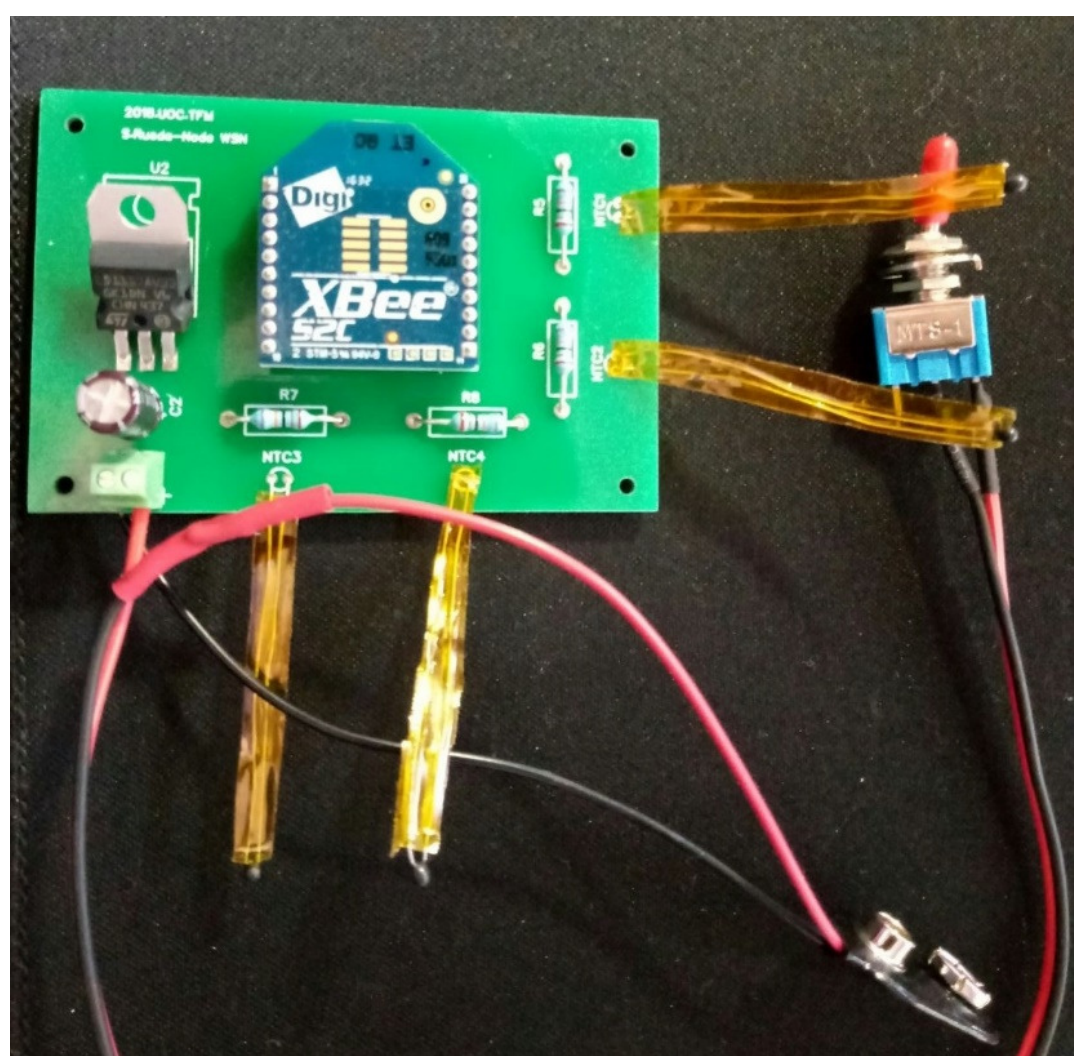
Figure 9. PCB with all integrated components. Thermistors are covered with Kapton tape to prevent short circuits and protect these components as they will be more